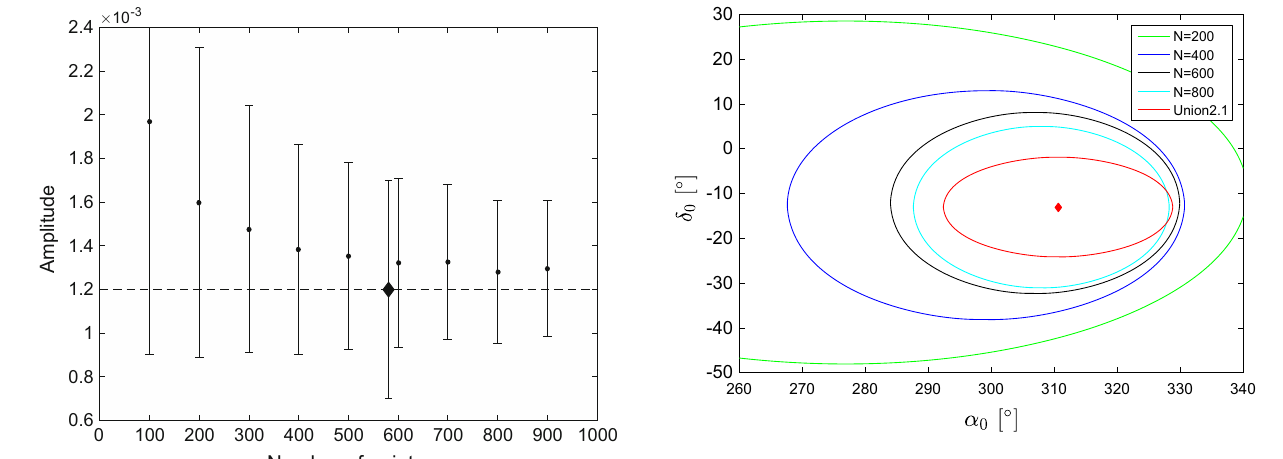
Fig. 2 The average 1 σ confidence region in the (α 0 ,δ 0 ) plane for dif- ferent number of GW events. The 1 σ confidence region of Union2.1 is also plotted for comparison ¯ d = (1 . 28 ± 0 . 01) × 10 − 3